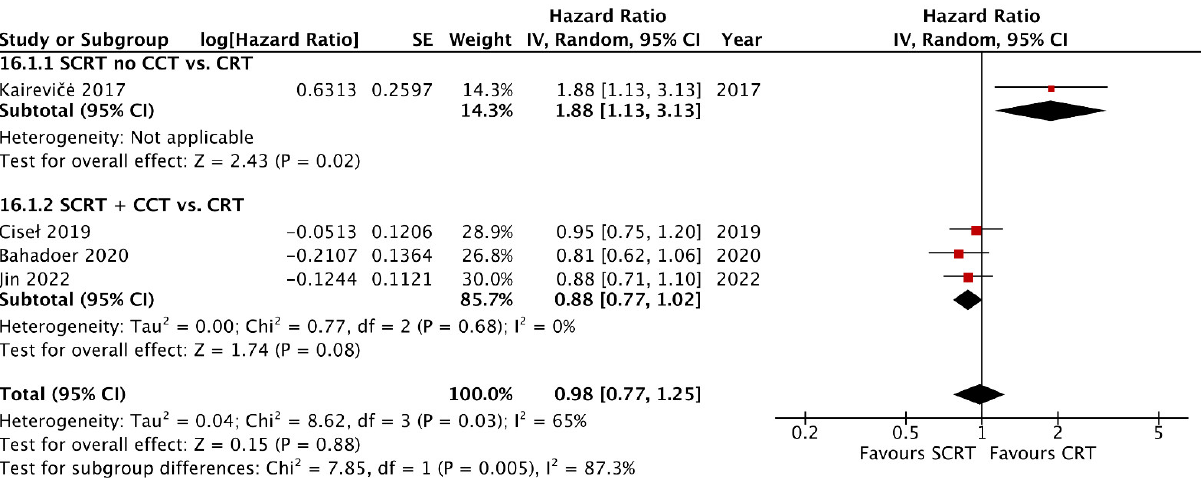
Figure 7. Forest plot of the disease free survival (DFS) by Hazard ratio (HR).